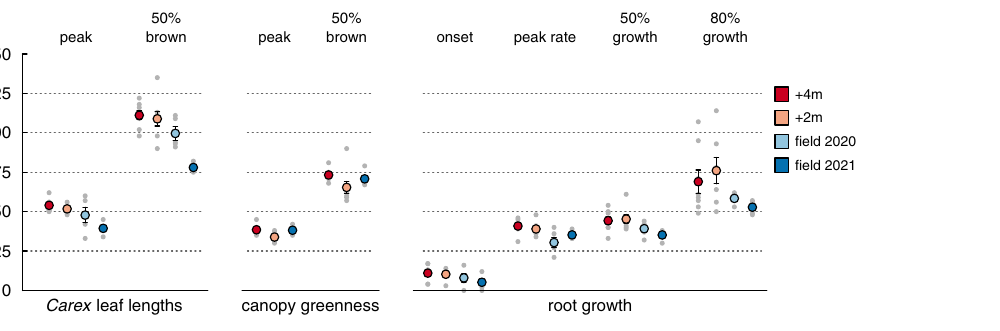
Fig. 3 | Timepoints related to growth and senescence for different growing season lengths (GSL). Peak green leaf length and senescence down to 50% browning for the dominant species Carex curvula , peak canopy greenness of the entire community and its decline to 50% and the onset of growth, highest growth